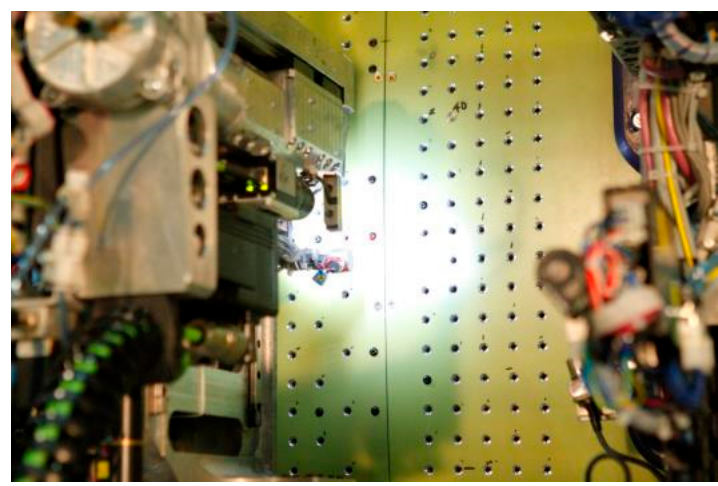
Figure 1. Inspection system implemented into a robot of an aeronautical manufacturing line.